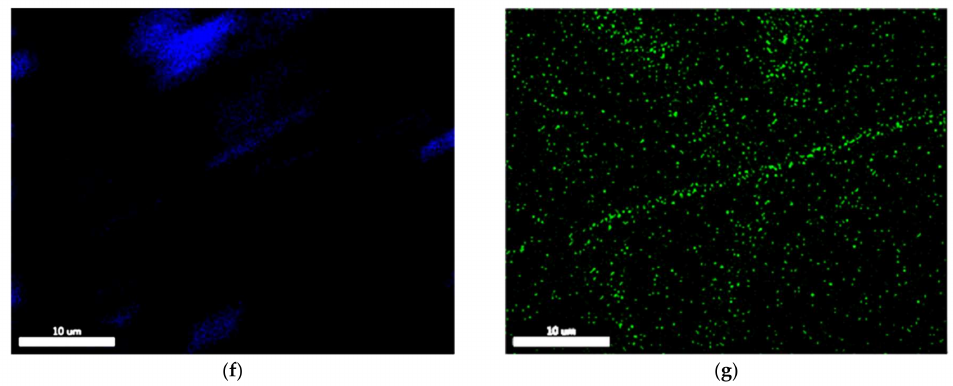
Figure 7. ( a ) Backscattered electron image of T6-treated M3S alloy after stabilization at 250 ◦ C for 1 h; ( b ) higher magnification image of the inset in ( a ); ( c – g ) X-ray maps showing the distribution of elements in ( b ): ( c ) Cu, ( d ) Al, ( e ) Mg, ( f ) Si, ( g ) Mn.